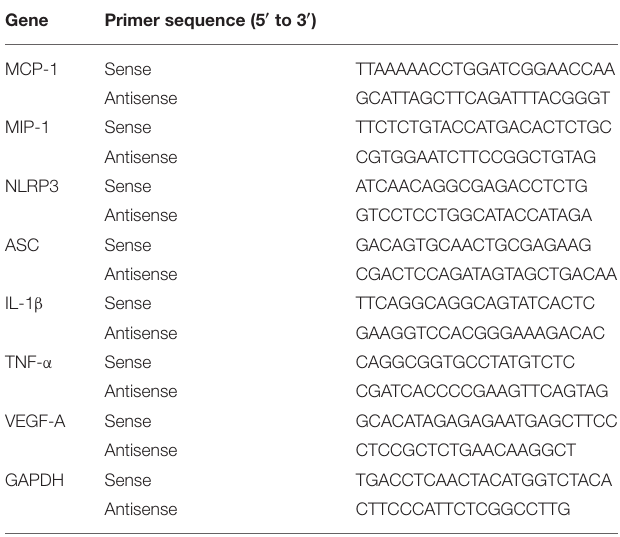
TABLE 1 | Primer sequences of mouse genes for real-time RT-PCR.